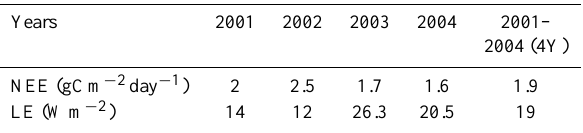
Table 2. Data errors that are taken into account within the cost func- tion (matrix R , Eq. 1). They were determined as the RMSE between a priori model outputs and observations (see